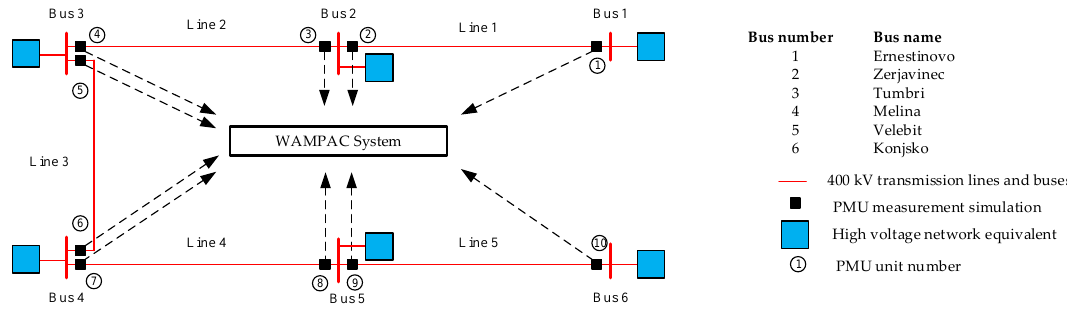
Figure 3. Scheme for CRO6BUS model in Matlab simulation environment.